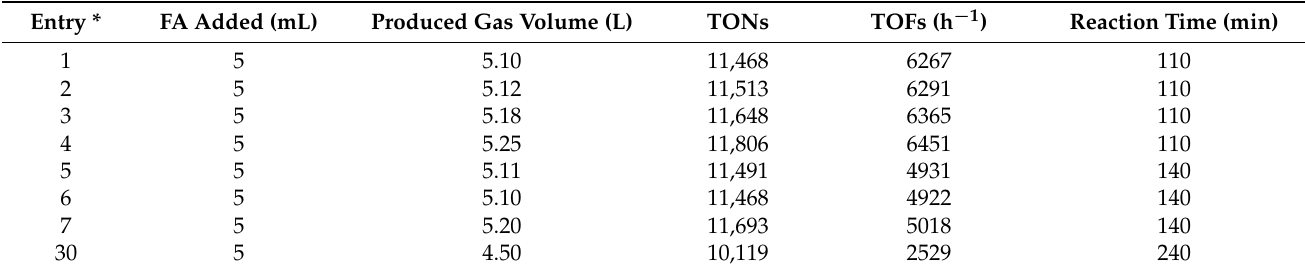
Table 1. Catalytic data for formic acid (FA) decomposition by (9 µ mol) of (Ru/PP3) in tri-glyme:water [v/v = 10:1] solution at 85 ◦